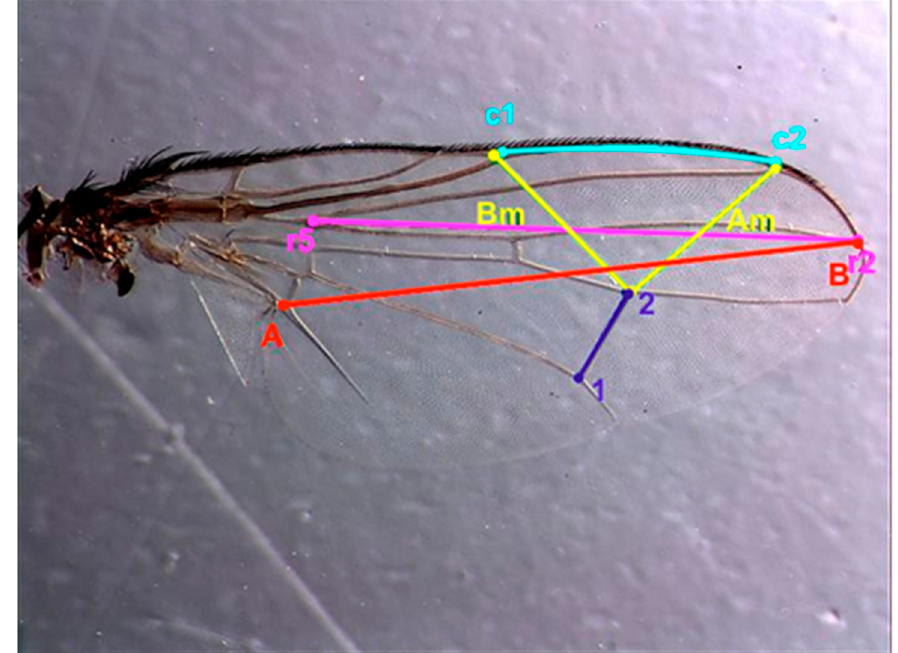
Figure 1. Image of the wing of Hydrotaea capensis taken with the binocular stereoscope with the measurements made using the TpsDig2 program according to different morphometric geometry studies. AB, in red; Am/Bm, in yellow; 1–2, in dark blue; c1–c2, in blue; r2–r5, in pink.